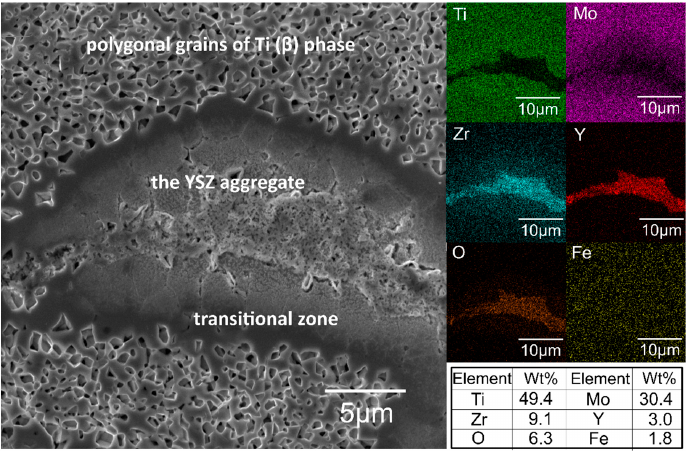
Figure 10. SEM microphotograph and EDS analysis of the 27–10